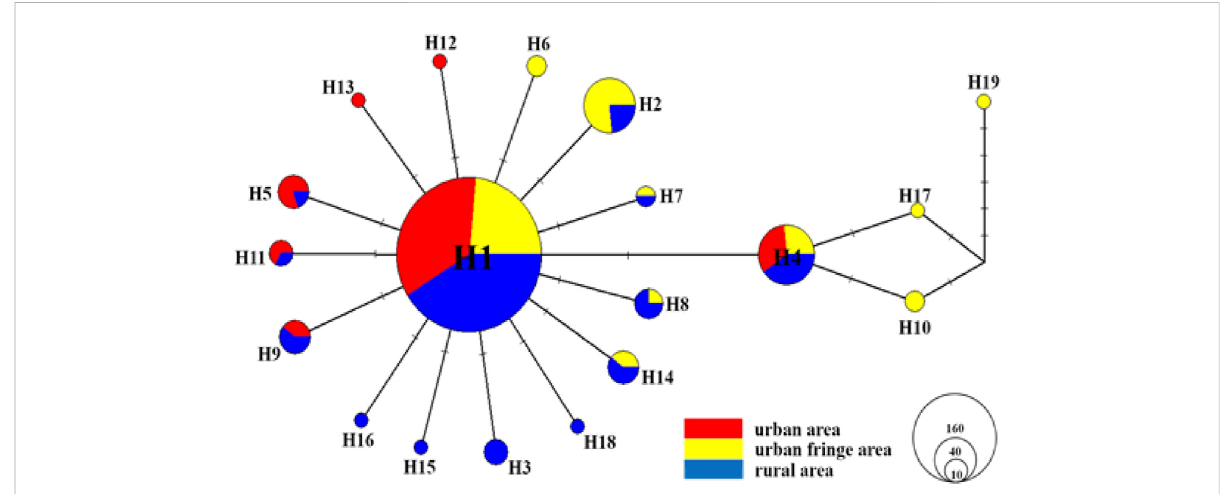
FIGURE 4 TCS haplotype networkfor the coxI gene ofall Ae. albopictus individuals( n = 329) from urban, urban fringe, and rural areas of Nanjing City. The sizes of circles are proportional to haplotype frequency, and each line segment represents a single mutation.